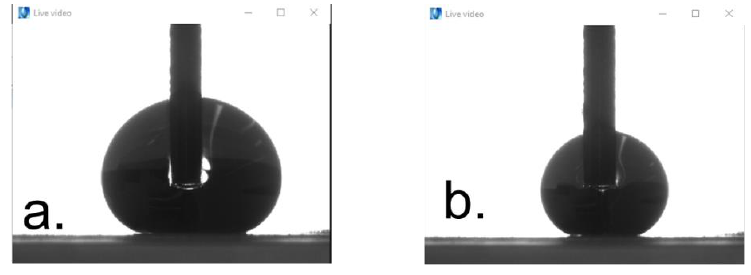
Figure 11: a. The ACA for the superhydrophobic area. b.The RCA for the superhydrophobic area. The measurements obtained using a goniometer and automated water dispenser with a volume rate of 0.08 ul/sec